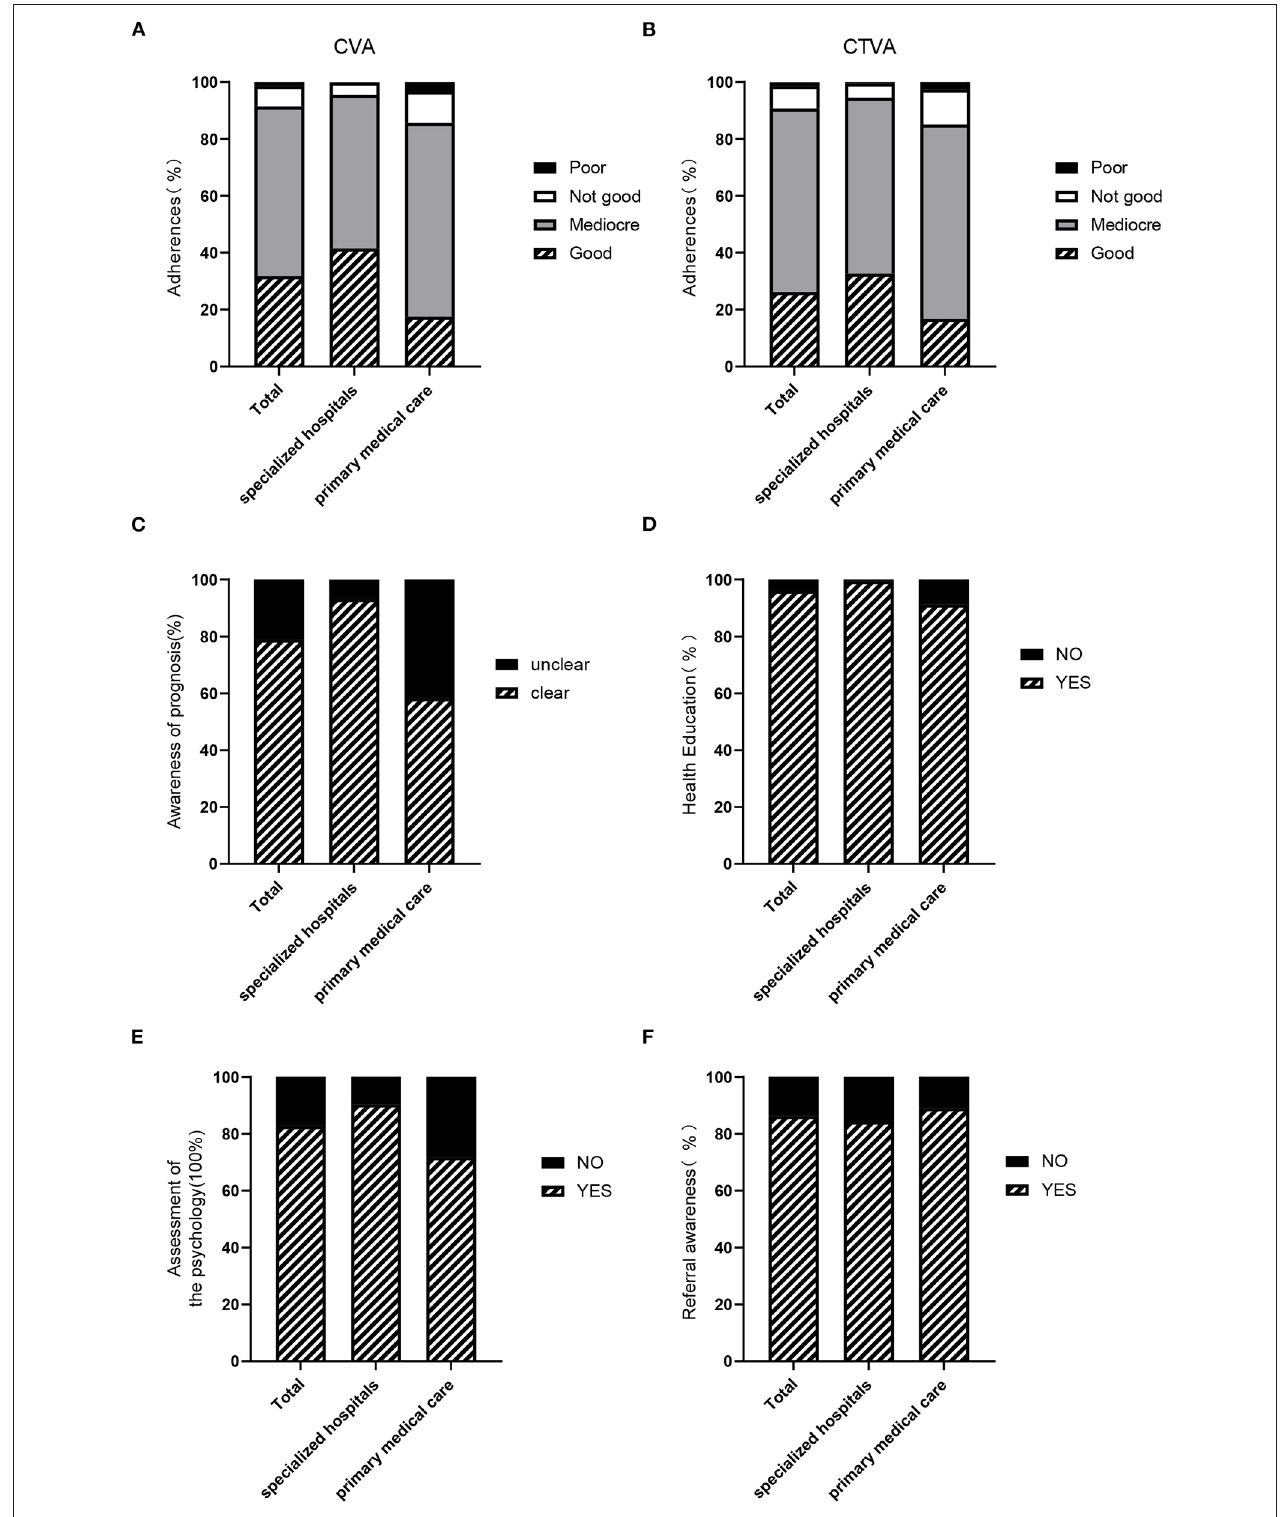
FIGURE 4 | Education regarding and management of CVA and CTVA. (A) The compliance of patients with CVA in all facilities, specialized hospitals and primary medical care facilities. (B) Compliance of patients with CTVA in all facilities, specialized hospitals and primary medical care facilities. (C) Prognosis awareness of atypical asthma among physicians in all facilities, specialized hospitals, and primary medical care facilities. (D) Psychological assessments in patients with atypical asthma by physicians in specialized hospitals and primary medical care facilities. (E) Referral awareness of physicians in all facilities, specialized hospitals and primary medical care facilities. (F) Health education among patients with atypical asthma by physicians in all facilities, specialized hospitals, and primary medical care facilities.